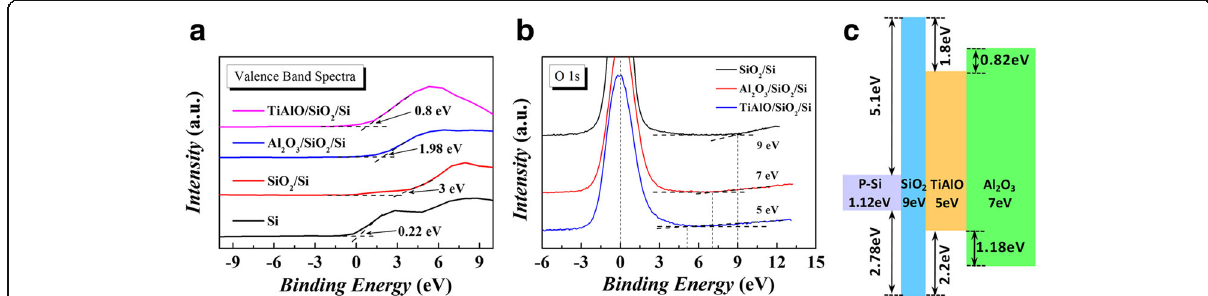
Fig. 4 ( Color online ) a Valance band spectra of P-Si substrate, SiO 2 /Si, TiAlO/SiO 2 /Si, and Al 2 O 3 /SiO 2 /Si structure. b O 1 s electron energy loss spectra of SiO